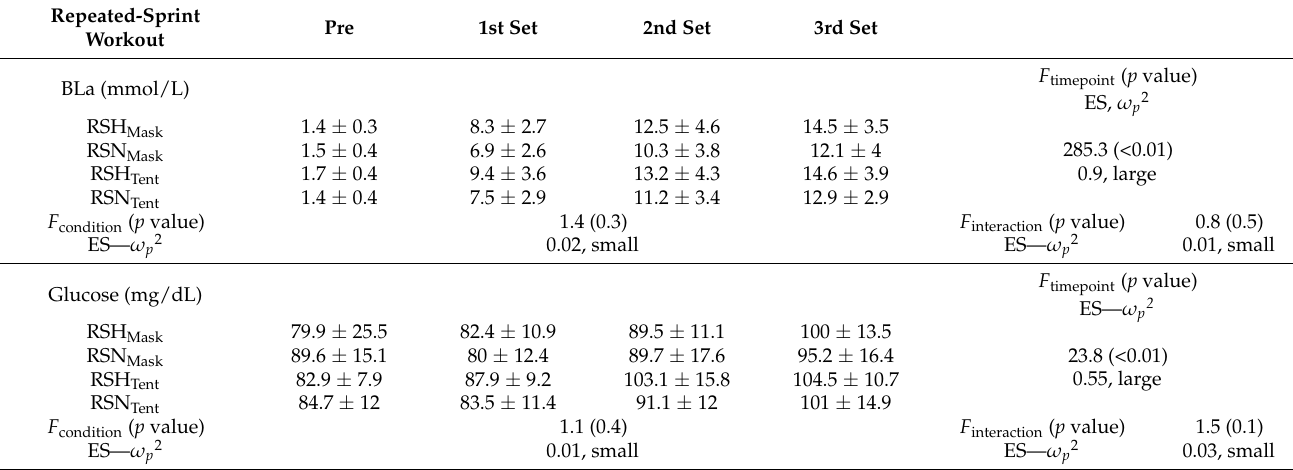
Table 2. Changes in biochemical responses due to repeated-sprint workout in normoxia and hypoxia. Repeated-Sprint